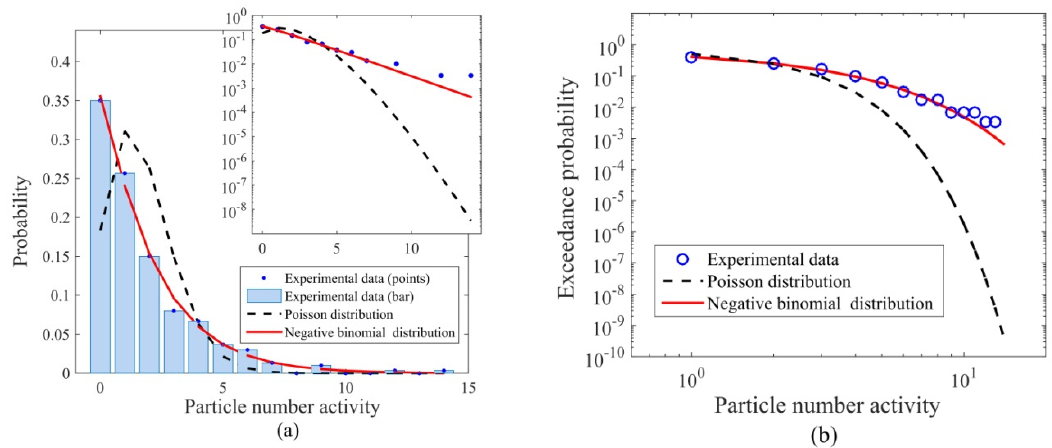
Figure 3. ( a ) Discrete probability distribution of the particle number activity for the interval Δ t = 1 s. The inset shows the same data with the fitted negative binomial and Poisson distributions on a semilog plot. ( b ) Exceeding probability of the particle number activity.